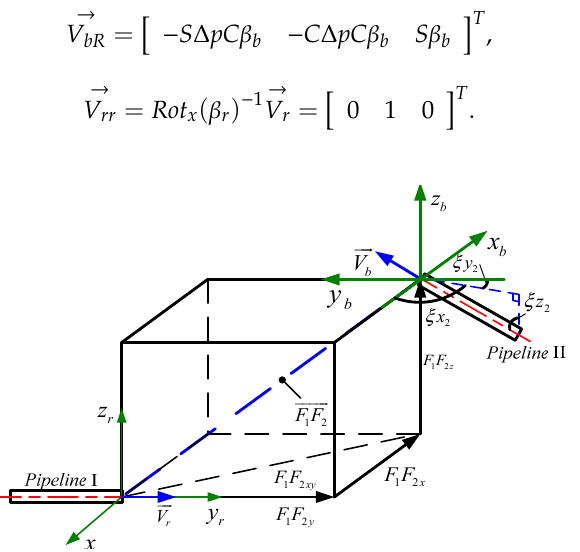
Figure 6. Schematic diagram of angle parameters.